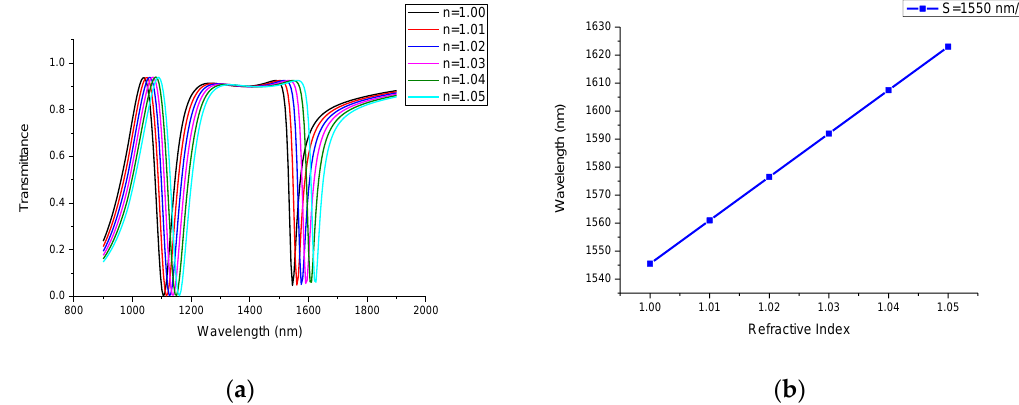
Figure 4. ( a ) Transmission spectrum of different refractive indices; ( b ) the fitting line of the wavelength of the Fano resonance dip with the changes of refractive index.